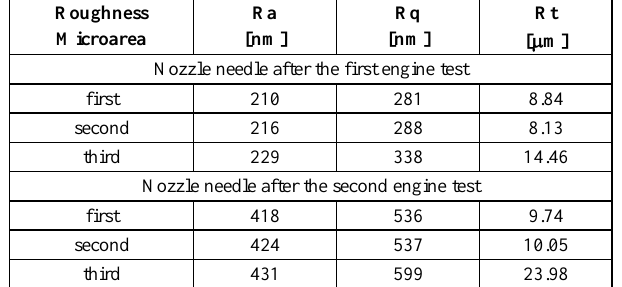
Table 3. Comparison of roughness results of evaluated needles surfaces Roughness